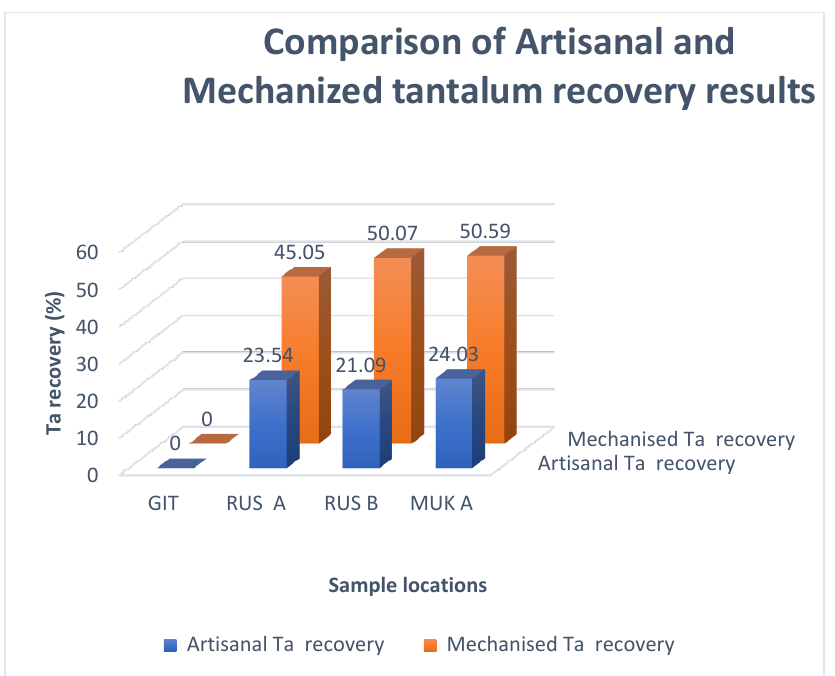
Figure 6. Comparison between the artisanal and mechanized recovery of tantalum.